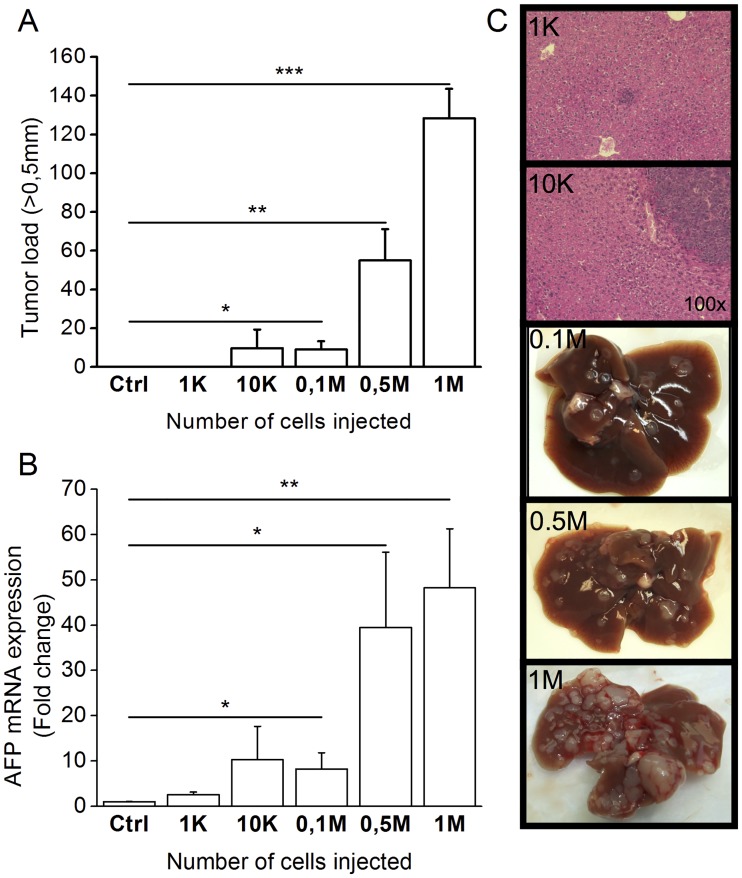
Dose-dependent tumor development following transfer of Dt81Hepa1-6 cells.Suspensions of Dt81Hepa1-6 cells [1K to 1M] were injected intrasplenically in C57BL/6 mice and animals were sacrificed after 28 days. (A) Manual count of tumor >0.5mm. (B) AFP (Afp) mRNA expression in liver homogenates by qPCR. (C) Representative microphotographs at 100x magnification of HPS-stained liver slice obtained after injection with 1K and 10K cells. Whole liver photographs of mice injected with 0.1M, 0.5M or 1M cells. Control mice were injected with 1M Hepa1-6 cells. (*P<0.05; **P<0.01; ***P<0.001).